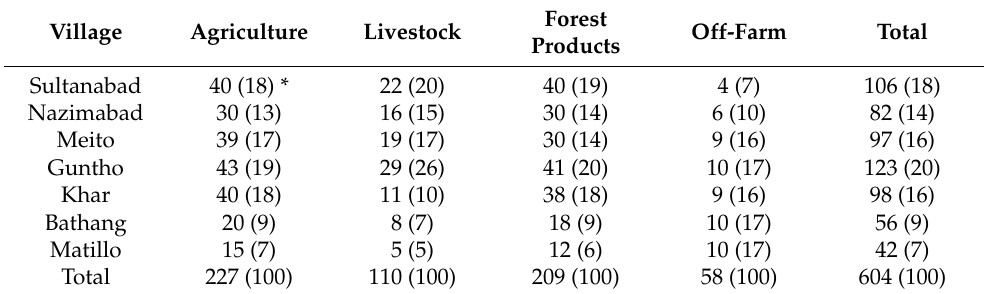
Table 3. Socio-economic survey in the region